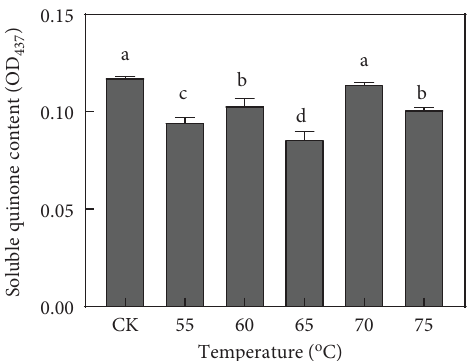
Figure 5: Soluble quinone content of “Yali” pear paste prepared under traditional and vacuum concentrations with diferent temperatures. CK: pear paste under traditional heating concen- tration; 55 ° C, 60 ° C, 65 ° C, 70 ° C, and 75 ° C: pear paste at diferent vacuum concentration temperatures; diferent letters indicated signifcant diferences among groups ( p < 0 . 05).